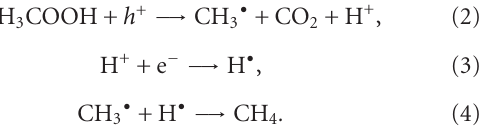
concentration of CH 4 in gaseous mixture was 0.88